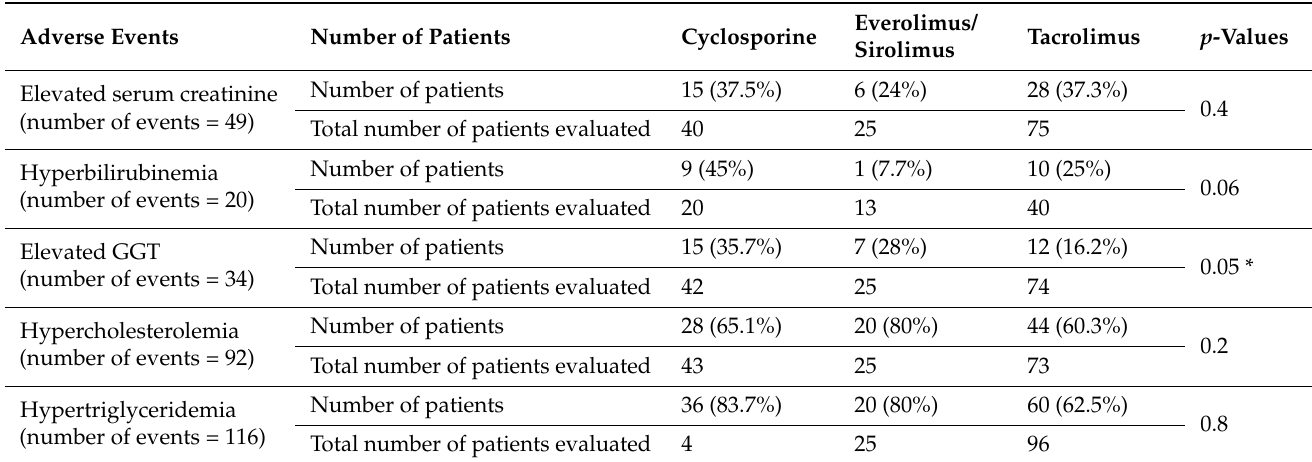
Table 8. Laboratory-related adverse events amongst the study